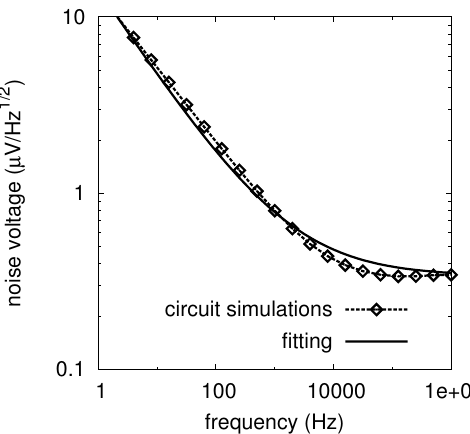
Figure 5. Low-frequency output noise voltage for a 36.8 GHz square-law detector, after [25]. The detector is realized using a differential configuration with two Hetero-junction Bipolar Transistors (HBTs). The detection is obtained using the non-linear characteristics of the HBT. The transistors are biased with a collector current of about 750 µ A. The input power is equal to 0.63 µ W, i.e. , − 32 dBm. The corresponding output voltage is V d = 60mV. The circuit simulations are compared with the standard Flicker noise model given in Equation (23) with the parameters of Table